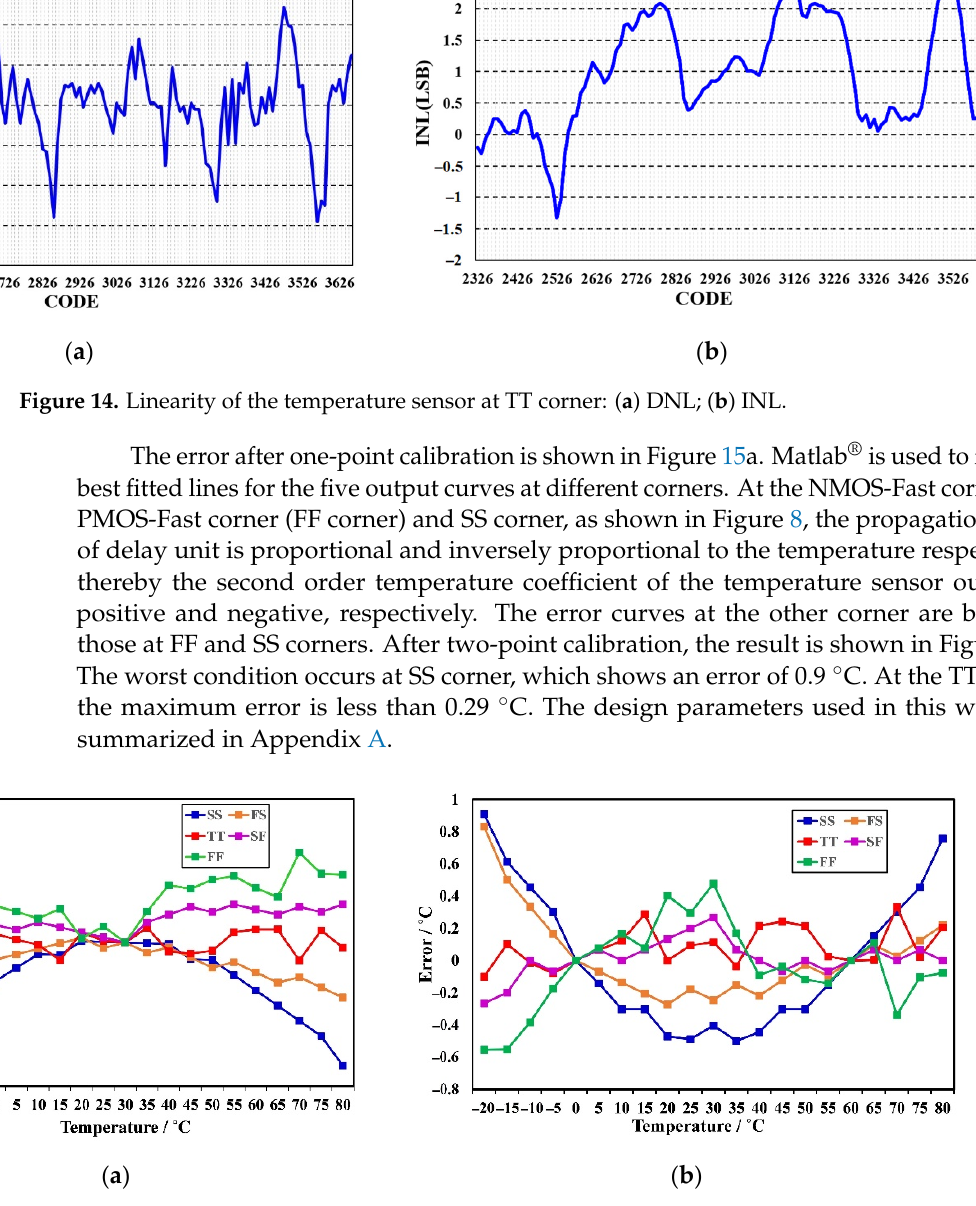
Figure 15. Post-simulation result of temperature error: ( a ) after one-point calibration; ( b ) after two-point calibration.